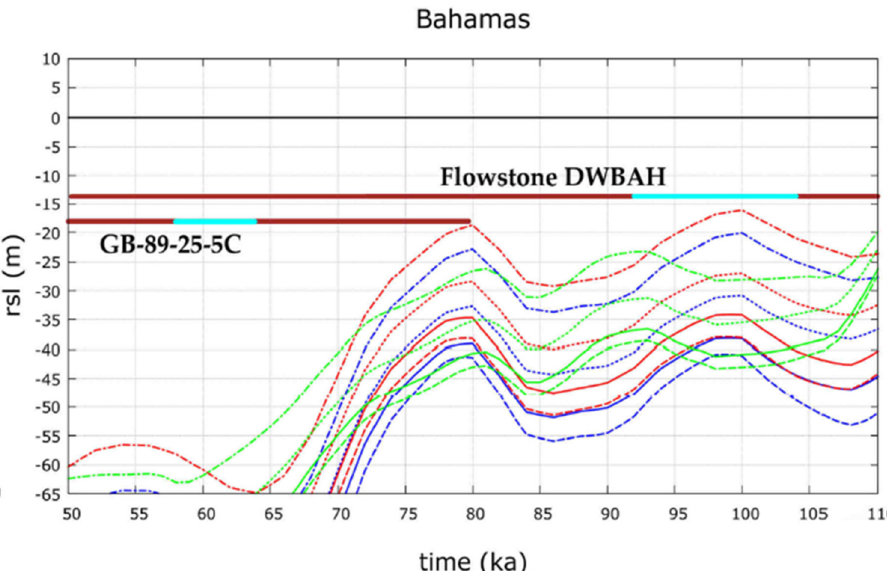
Figure 3. Constraints on MIS 3 depth from the Bahamas. The submerged speleothem GB-(89) sampled in the Blue Hole (Bahamas) at − 18.1 m [56] shows a hiatus between 63.7 and 58.5 kyrs. Glacial and hydro-isostatic Adjustments (GIA) at Bahamas is similar to that of the Central Mediterranean sea [59]. Predicted RSL curves for the ICE-5G (red curves), ICE-6G (green curves), and ANICE-SELEN (blue curves) ice sheet models in combination with MVP 1–3 mantle viscosity profiles (solid, dashed and dotted lines, respectively) at each site and with respect to the measured elevations.